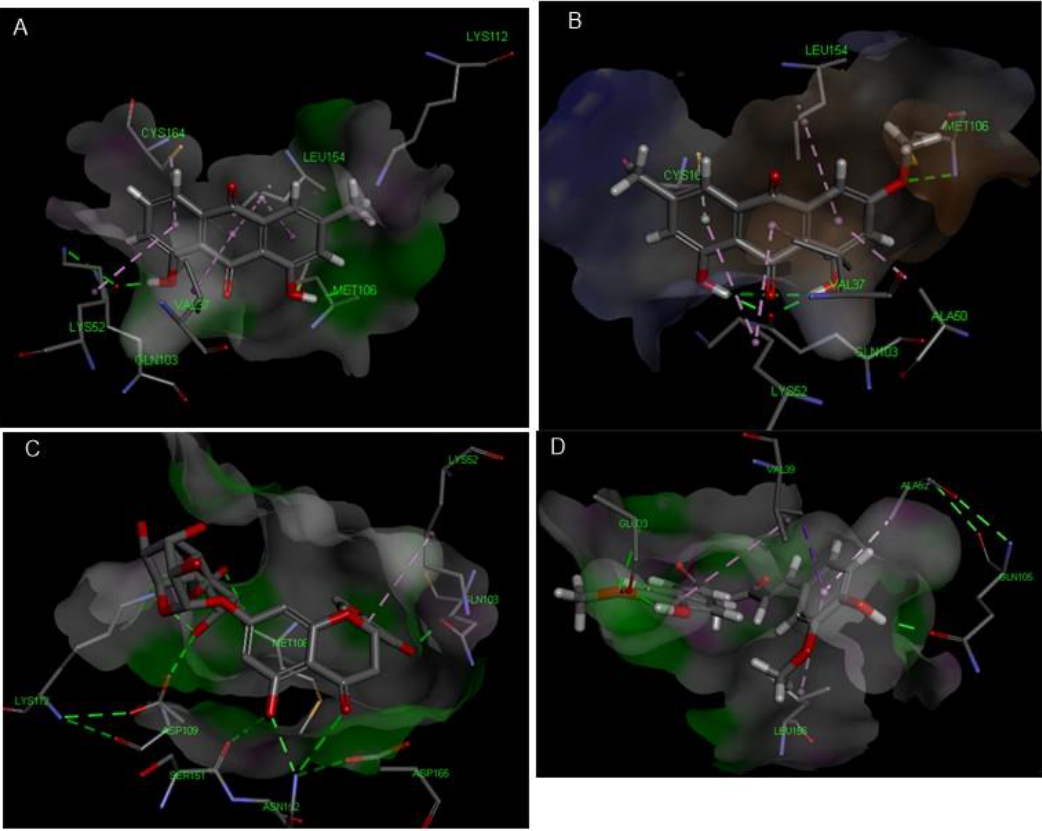
Figure 10. Molecular interactions of chrysophanol ( A ), physcion ( B ), hesperidin ( C ) and curcumin ( D ) with ERK1/2 MAPK (PDB ID: 5NHF).